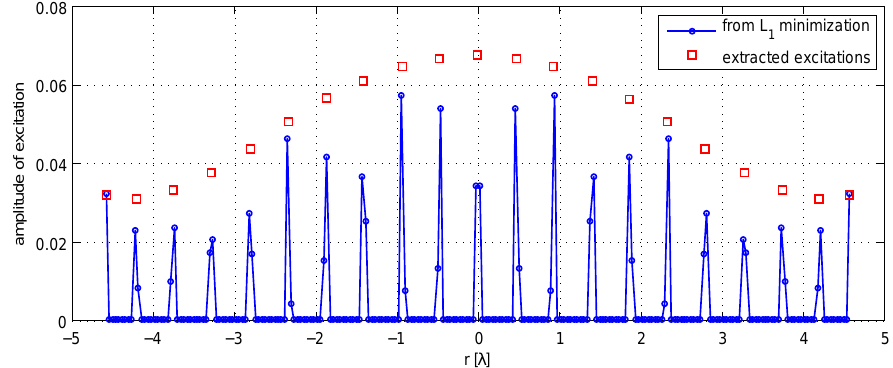
Figure 1. Excitations found by (cid:96) 1